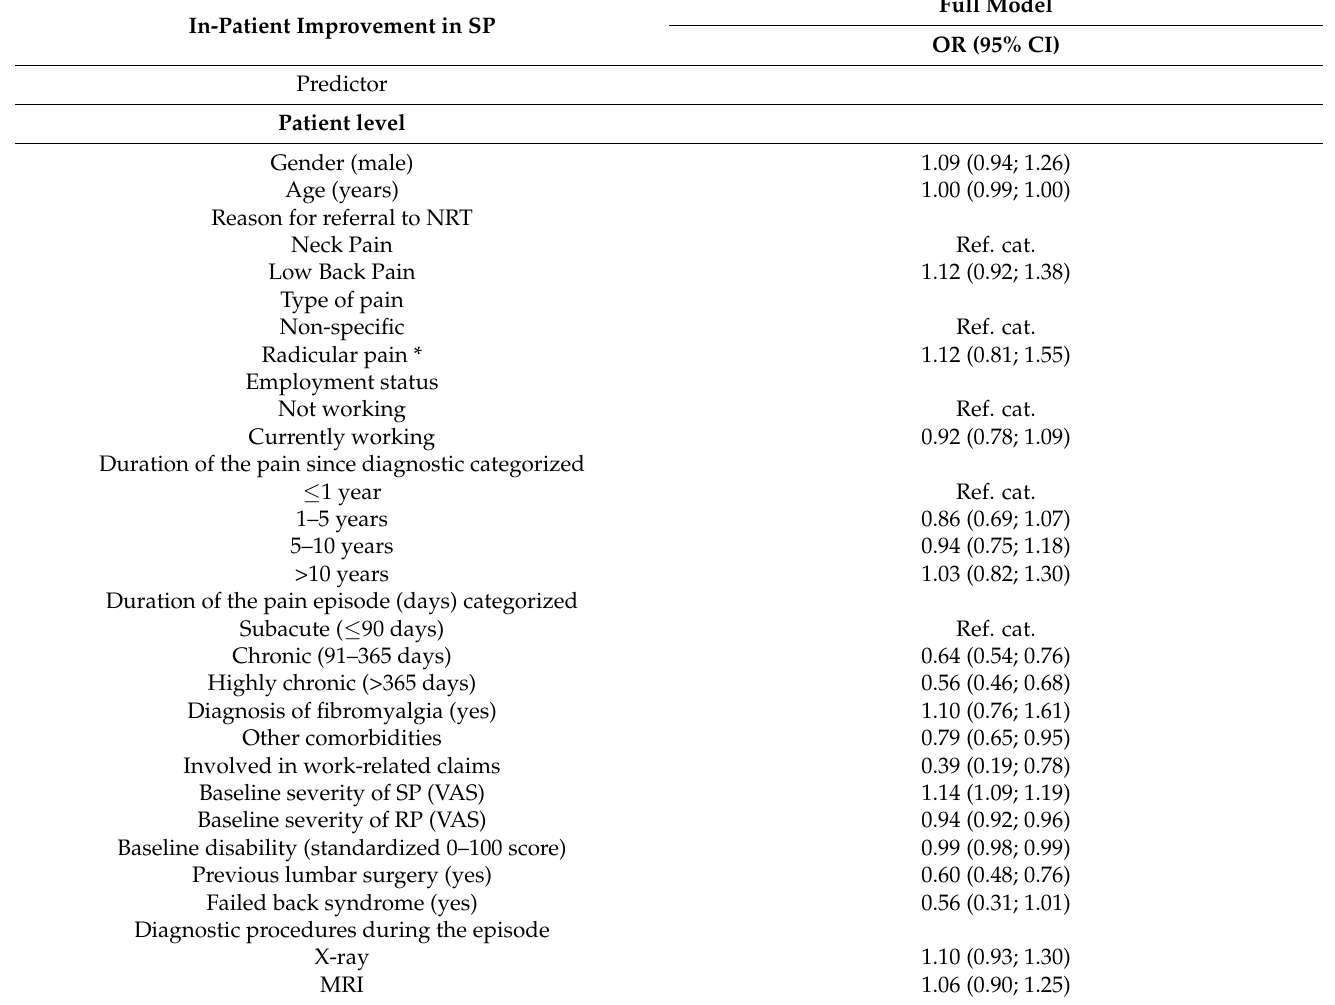
Table 6. Multilevel full model to determine the strength of the association between predictors and improvement in spinal pain (SP) ( n =